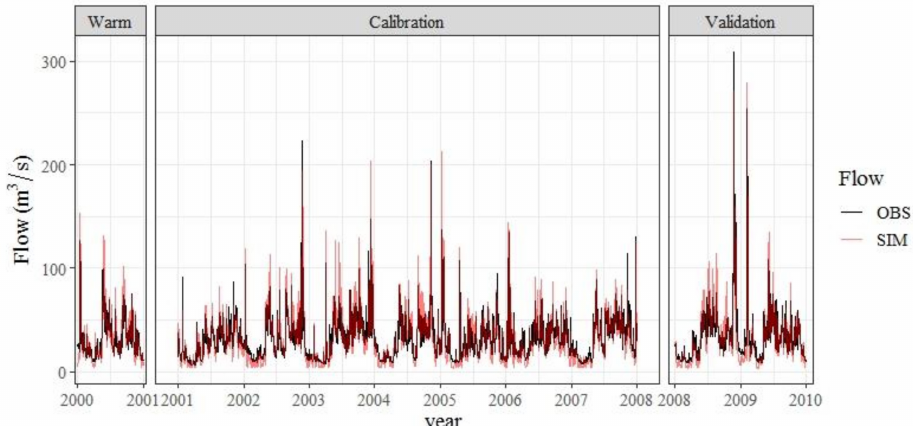
Figure 4. Daily flow observed and simulated data for the Pejibaye river